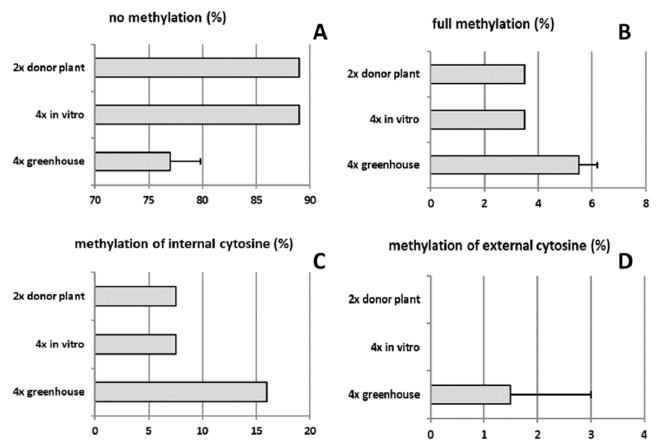
Figure 7. Type of DNA methylation in tetraploid apple cultivar ‘Free Redstar’: ( A ) no methylation, ( B ) full methylation, ( C ) methylation of internal cytosine, and ( D ) methylation of external cytosine. Error bars represent standard deviations.